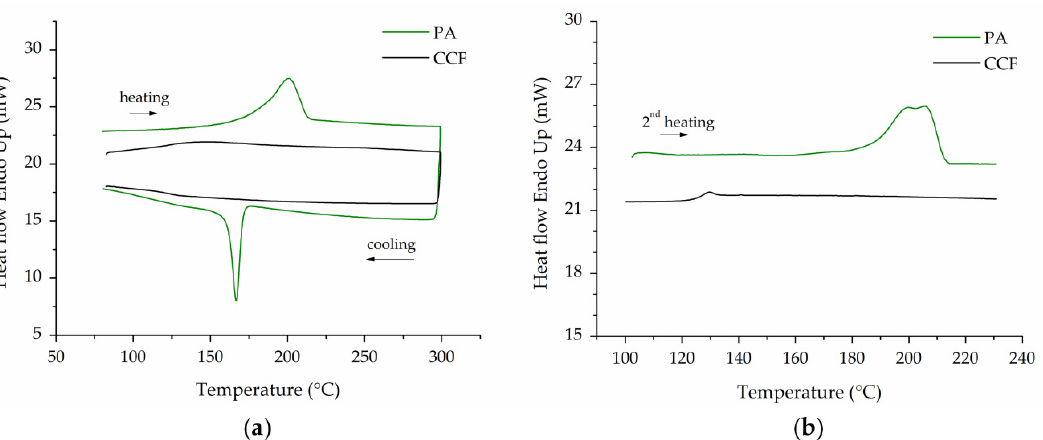
Figure 2. ( a ) DSC 1st heating–cooling curves; ( b ) DSC 2nd heating curves of PA and CCF filaments. The glass transition of CCF tow is clearly visible in the 2nd heating step.